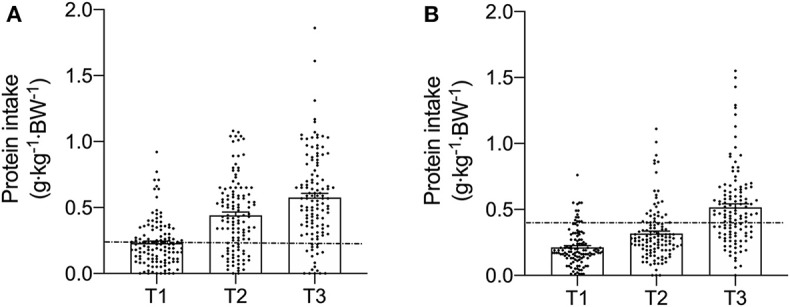
Meal-specific relative protein intakes for each meal consumed at breakfast (T1), lunch (T2), and dinner (T3) in young (A) and old (B). Dashed lines represent threshold protein intakes of 0.24 and 0.4 g·kg−1, suggested for maximal stimulation of MPS in young and older individuals, respectively.